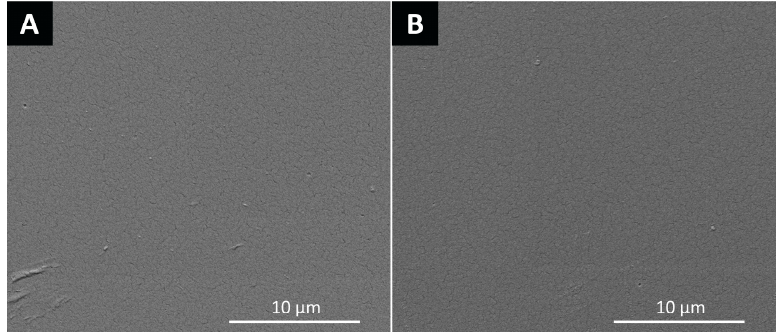
Figure 2. Scanning electron microscopy (SEM) micrographs of the surface of: ( A ) nonloaded and ( B ) loaded hydroxypropyl methylcellulose films.